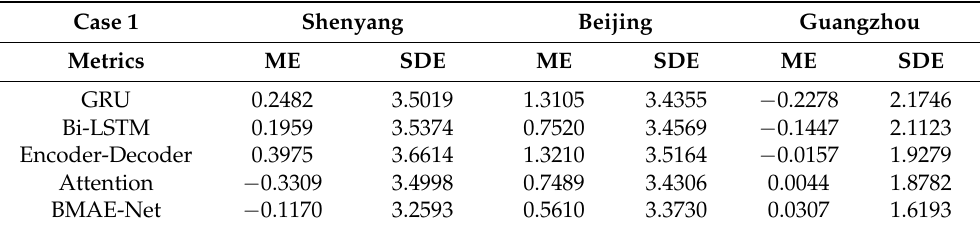
Table 7. The model parameters.